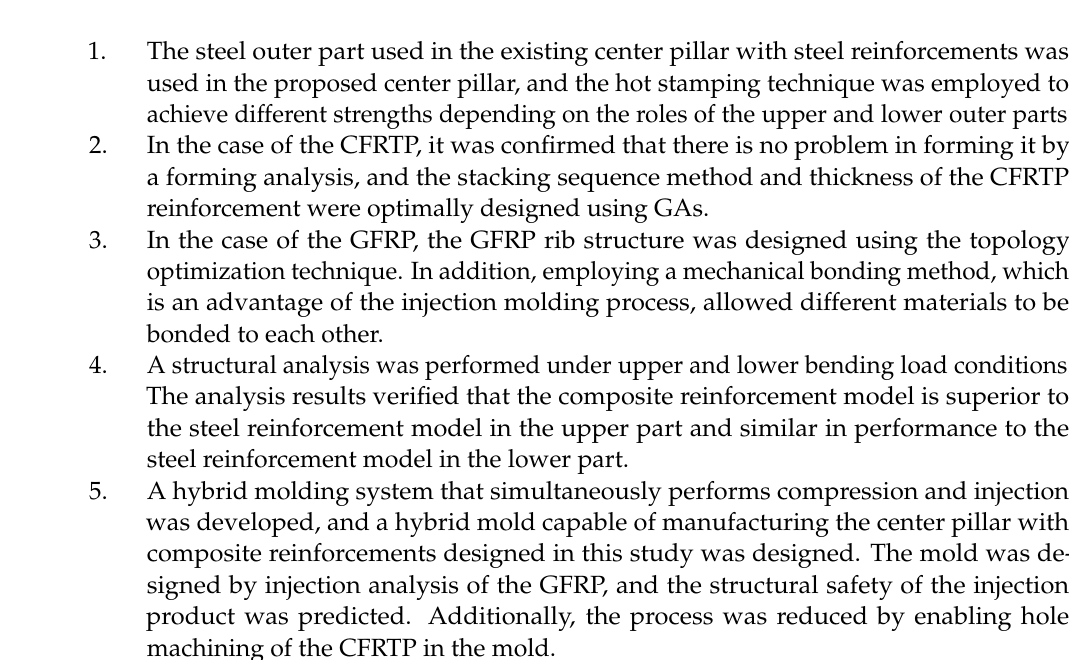
Figure 25. Final design of the hybrid mold: ( a ) top view of upper mold, ( b ) top view of lower mold, ( c ) isometric view of upper mold, ( d ) isometric view of lower mold, and ( e ) isometric view of entire mold.